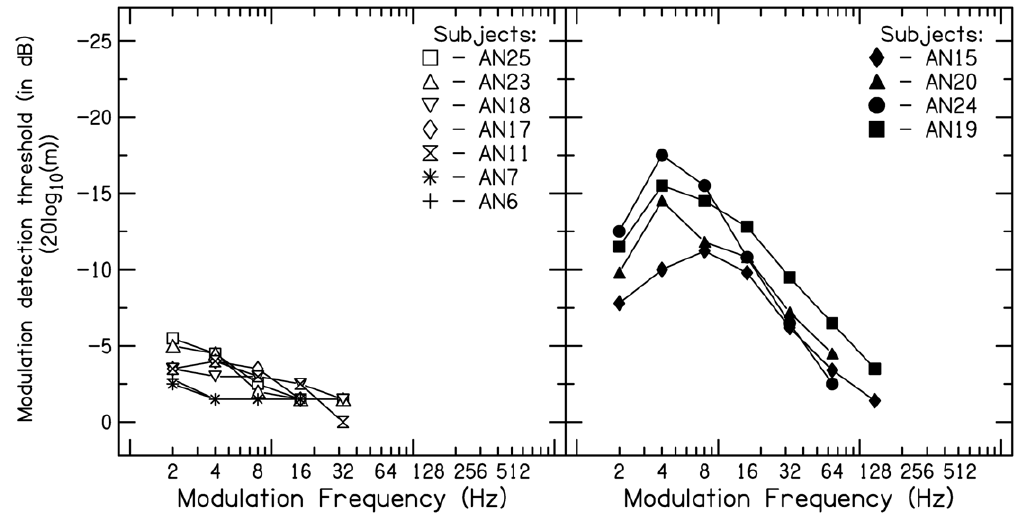
Figure 5. Atypical temporal modulation transfer function (TMTF) pattern measured in listeners with AN. Left panel shows flat pattern and right panel shows band pass pattern. In each panel, the ordinate is the amplitude modulation detection threshold, expressed in decibels as 20 log m and abscissa is modulation frequency (Hz).